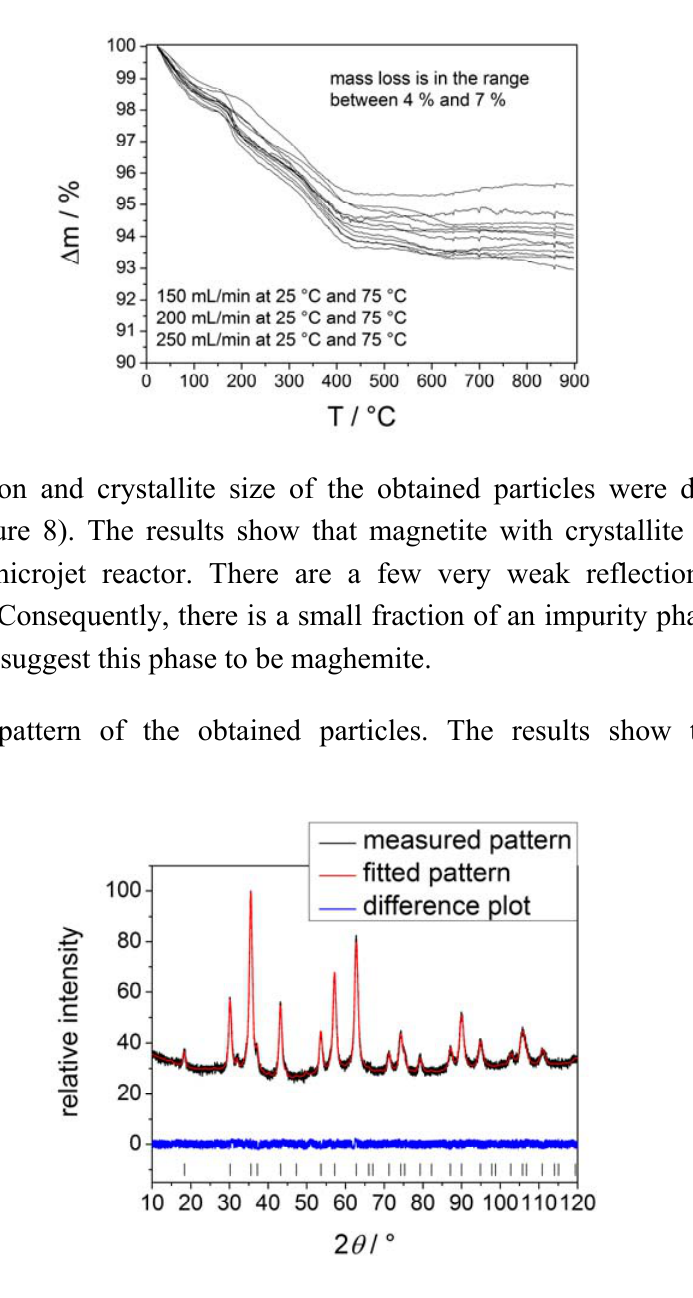
Figure 7. Thermo gravimetric analysis of the final products. The samples show a mass loss of between 4 and 7%.